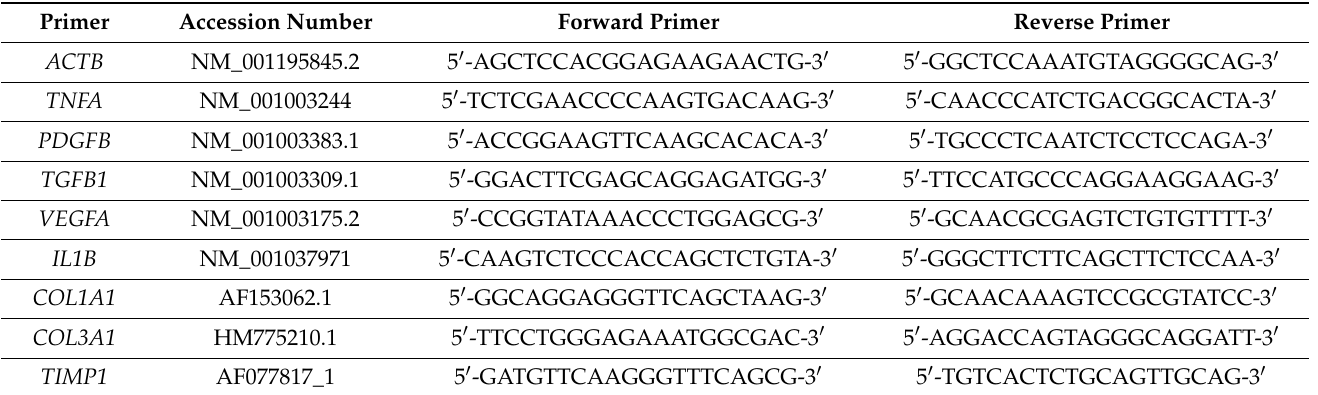
Table 3. Oligonucleotide